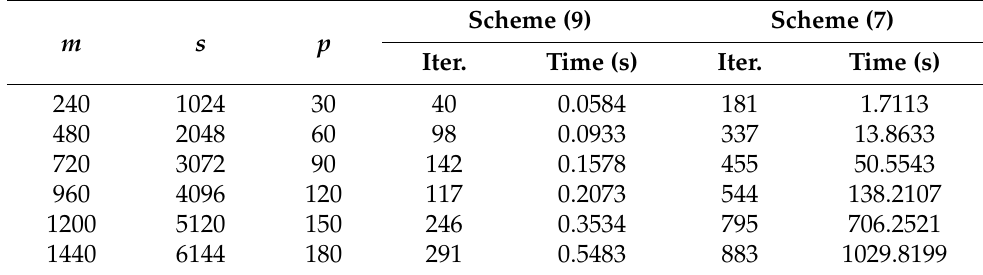
Table 2. Numerical results of scheme (9) and scheme (7) as regards Example